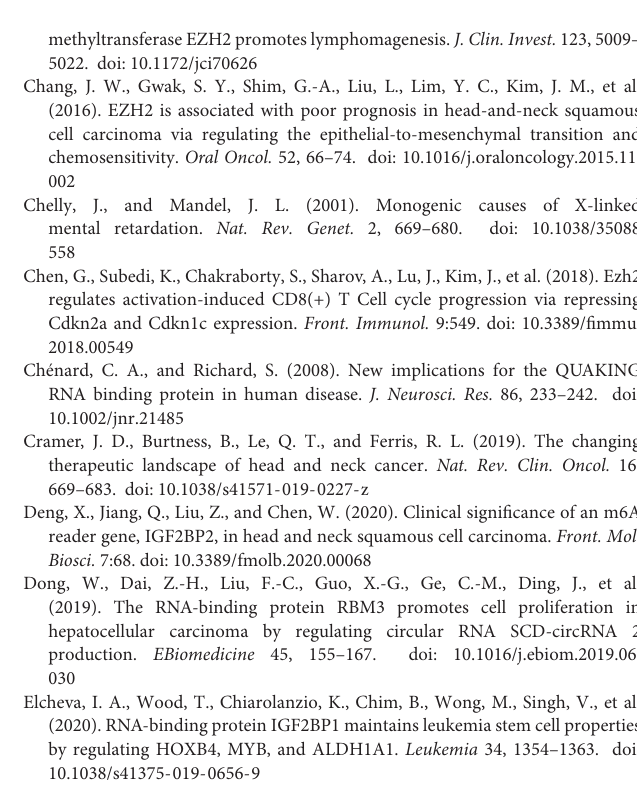
Supplementary Figure 1 | The distribution of the DERBPs on chromosomes. A total of 1,542 human RBPs distributing on all chromosomes, including sex chromosome X and Y. Supplementary Figure 2 | Construction of a prognostic risk model using LASSO regression analysis. (A) Prognostic-related DERBPs identified by LASSO algorithms in the TCGA training set. (B) The prognostic risk model constructed with LASSO coefficient values in the TCGA training set. Supplementary Figure 3 | Other single GSEA figures of the high-risk and low-risk groups. Single GSEA plots showing enriched pathways in the high-risk and low-risk groups displayed in Table 3, except the B cell receptor signaling pathway and T cell receptor signaling pathway. Supplementary Table 1 | The patient information of TCGA training set. Supplementary Table 2 | The patient information of TCGA test set. Supplementary Table 3 | The list of 1,542 RBP genes. Supplementary Table 4 | Ninety-two differentially expressed RBP genes. Supplementary Table 5 | The top 10 and 30 enriched pathways of the high and low risk group,